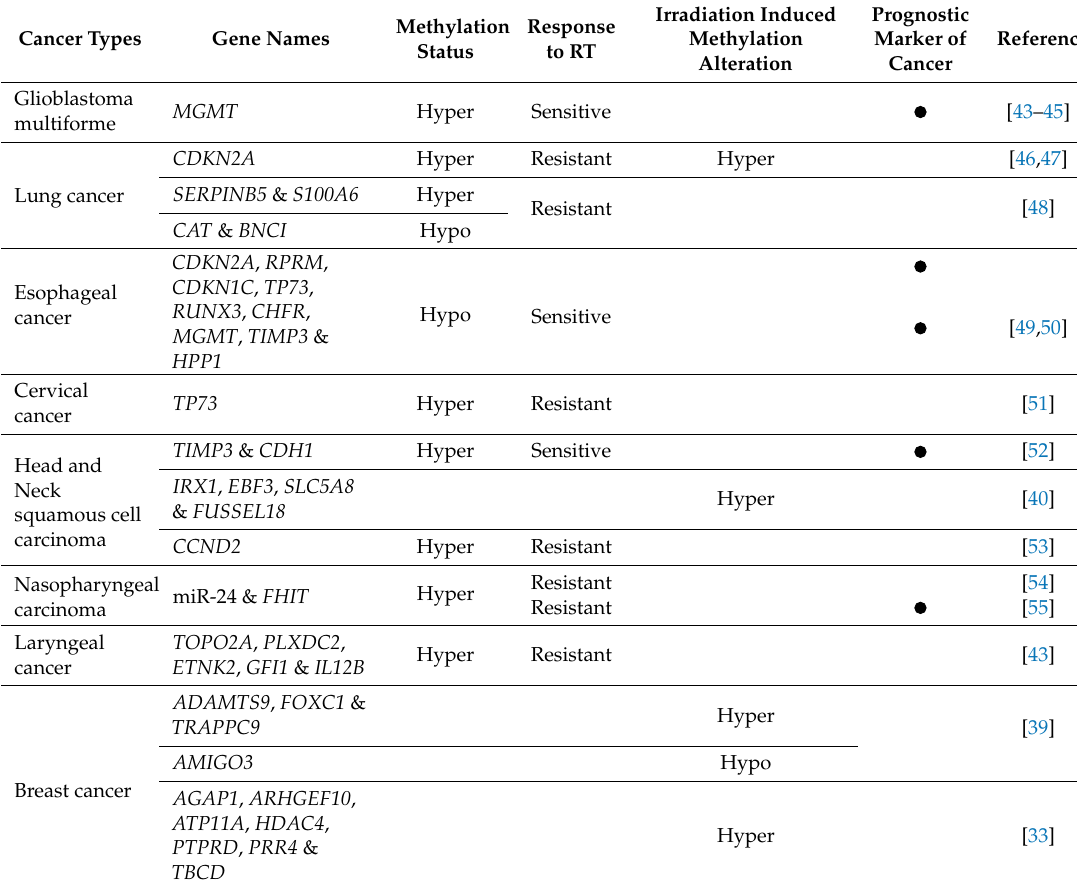
Table 1. Summary of the relevant DNA methylation of genes associated with radiotherapy/response in various